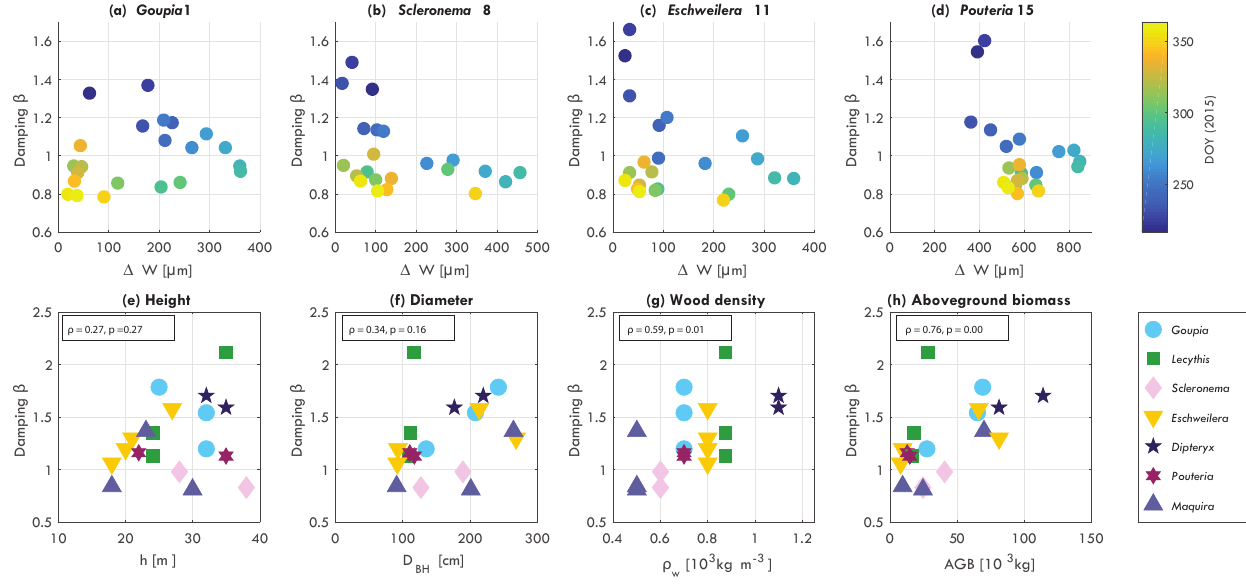
Figure 6. Damping coefficient β (for fitted function αC d vs. u ) for a single (a) Goupia , (b) Scleronema , (c) Eschweilera , and (d) Pouteria tree, vs. water-related stem variation (cid:49)W , colored by day of year (DOY, 2015), and average damping coefficient β in relation to (e) tree height h , (f) diameter at breast height D BH , (g) wood density, and (f) aboveground biomass (AGB), for each measured tree, including Pearson’s ρ